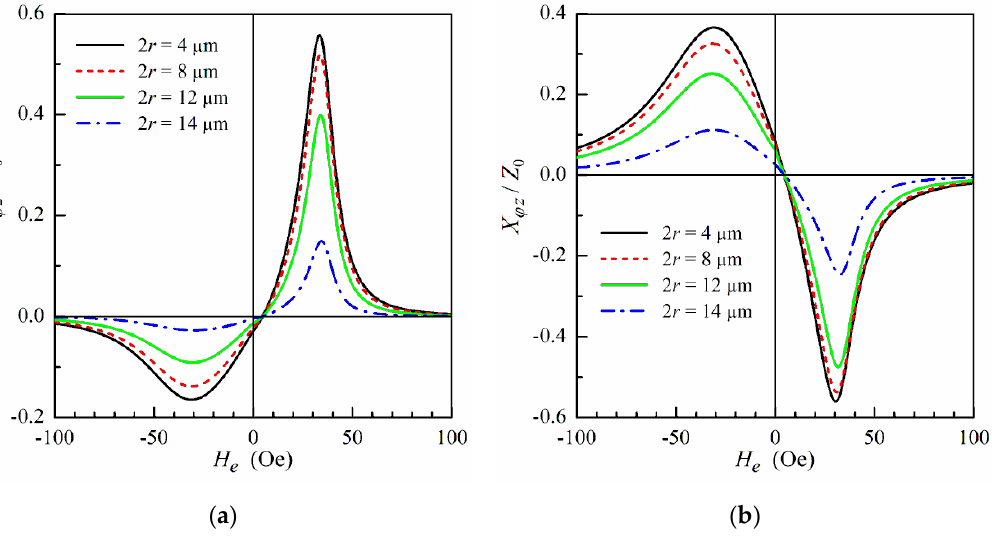
Figure 3. ( a ) The real part R ϕ z and ( b ) the imaginary part X ϕ z of the ODMI as a function of the external field H e at f = ω /2 π = 100 MHz for different values of the bias current I b . Parameters used for calculations are 2 R = 15 µ m, 2 r = 8 µ m, M = 900 G, σ = 5 × 10 15 s − 1 , κ = 0.15, H a ,1 = 5 Oe, H a ,2 = 30 Oe and ψ 2 = − 0.05 π .